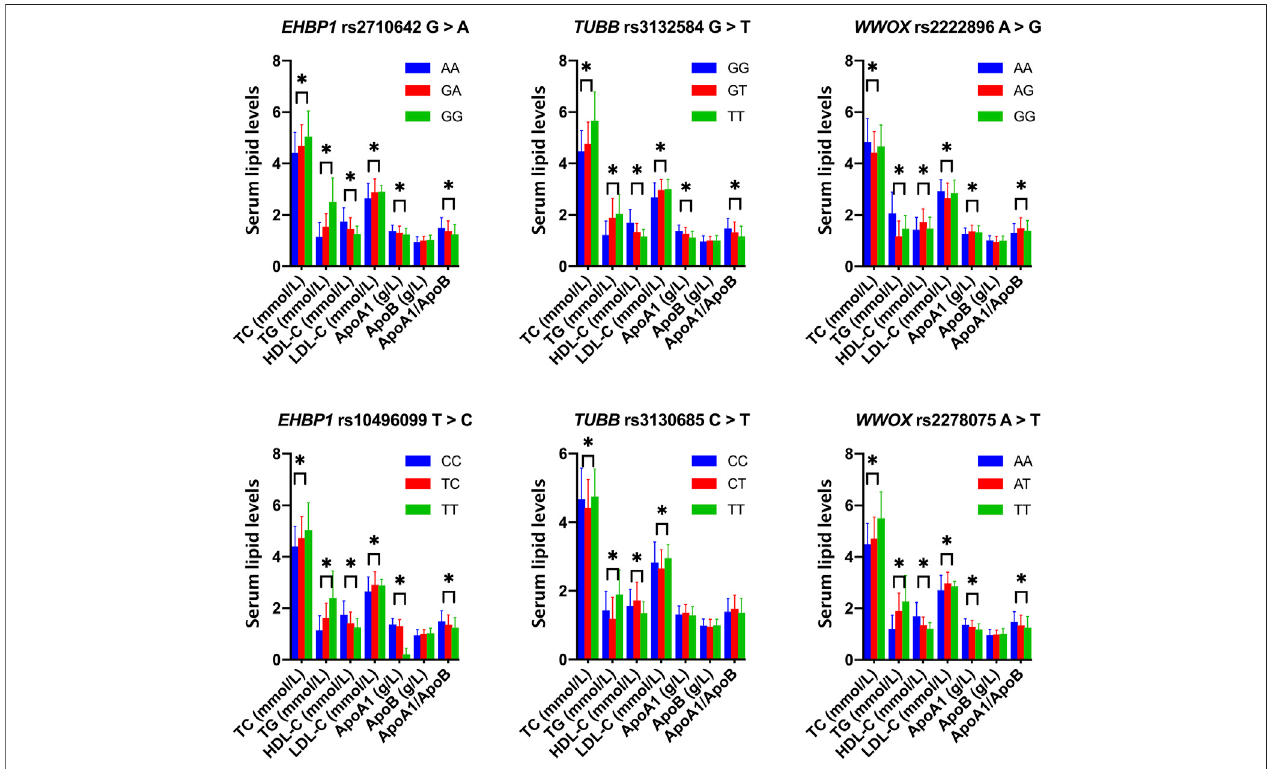
FIGURE 1 | Associations between the 18 EHBP1 , TUBB , and WWOX genotypes and serum lipid parameters in the control group. * p < 0.0004 was considered statistical signi fi cance after the Bonferroni correction (6 SNPs × 3 genotypes × 7 lipid phenotypes).